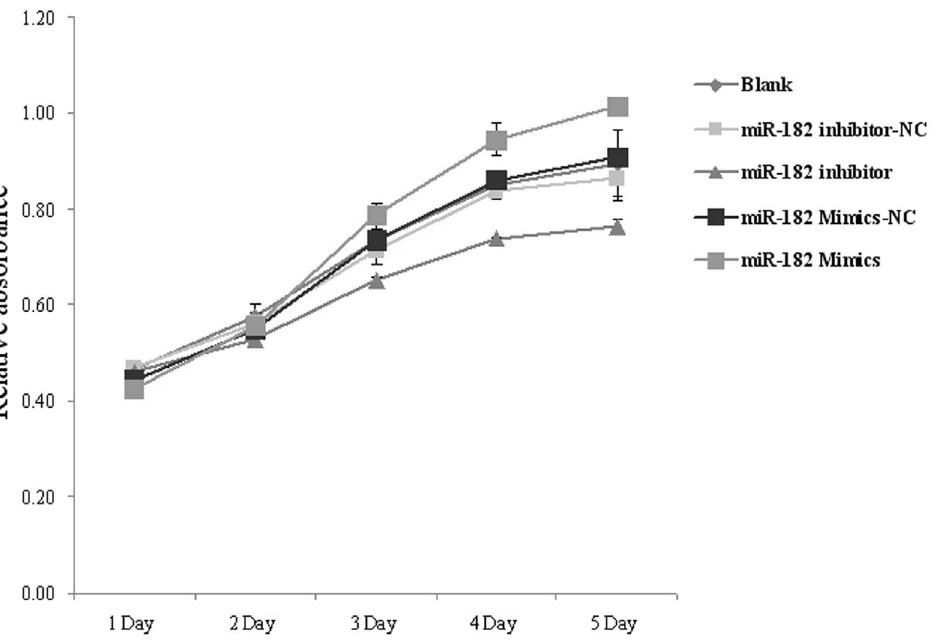
Figure 5. Viability of PC-3 cells transfected with miR-182 mimics or inhibitors was measured by MTT assays. Blank presents blank control. UV-visible absorbance was measured at 490 nm. The relative absorbance was significantly different 3 days after transfection ( P , 0.05). Values represent means from three separate experiments.